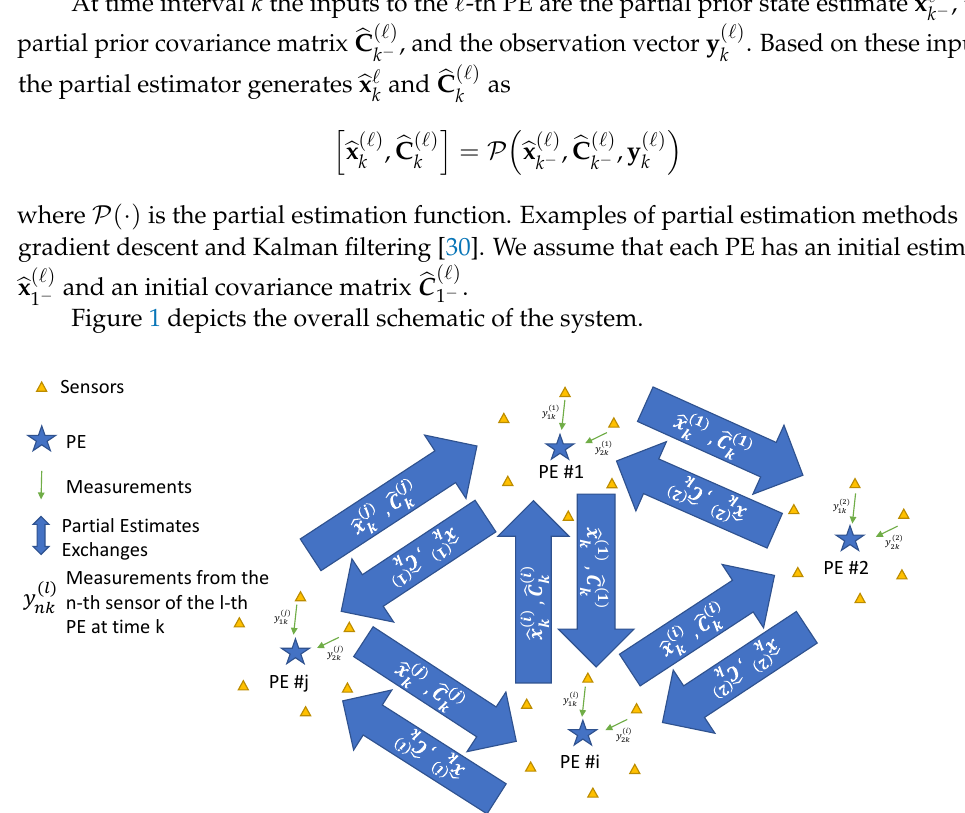
Figure 1. The overall schematic of the